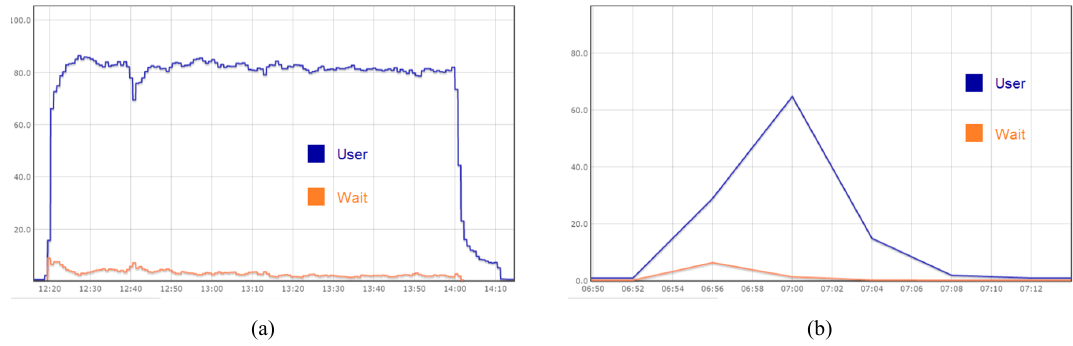
Figure 7 . JEODPP cluster CPU workload (472 cores): ( a ) for the SUMO workflow applied to 11,647 S1 products (19 TB); and ( b ) for the Matlab script-based meta-information extraction. The blue line denotes the load of the user-triggered processes and the orange line represents the system waiting time. Horizontal axis is time in HH:MM and vertical axis is per cent.